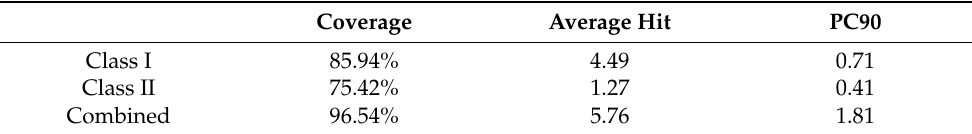
Table 2. Population coverage analysis for the combined peptide set.